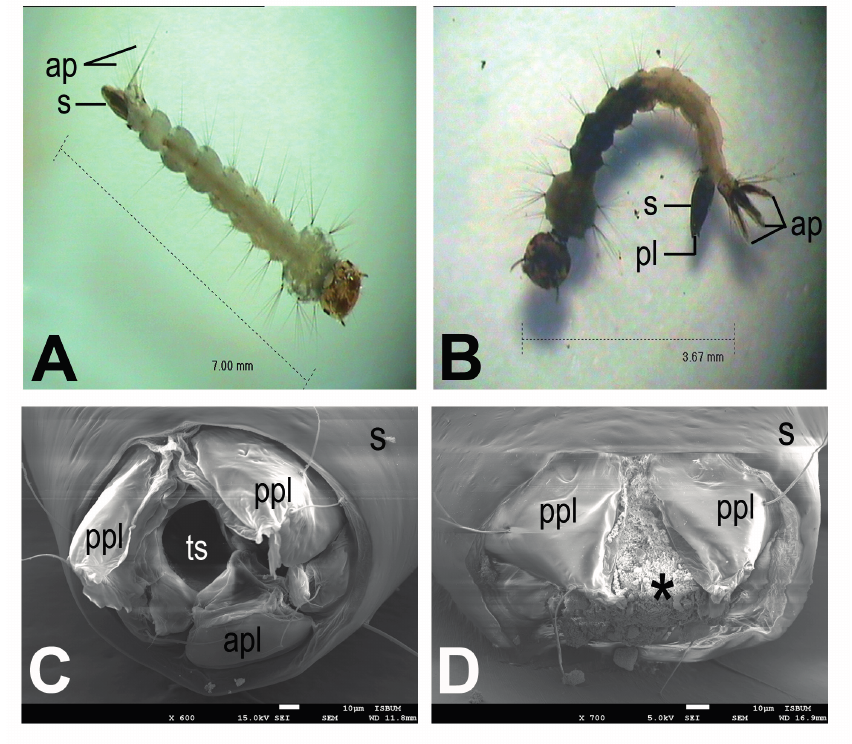
Figure 1. Photographs of Aedes albopictus larvae: ( A ) larva of negative control; ( B ) larva treated with chloroform extract of Bryopsis pennata showing darkened body parts and anal papillae; ( C ) larva of negative control showing intact spiracular apparatus; ( D ) larva treated with chloroform extract of B. pennata showing spiracular apparatus with damaged inner structures ( * ). ap, anal papillae; apl, anterior perispiracular lobe; pl, perispiracular lobes; ppl, posterior perispiracular lobe; s, siphon; ts, terminal